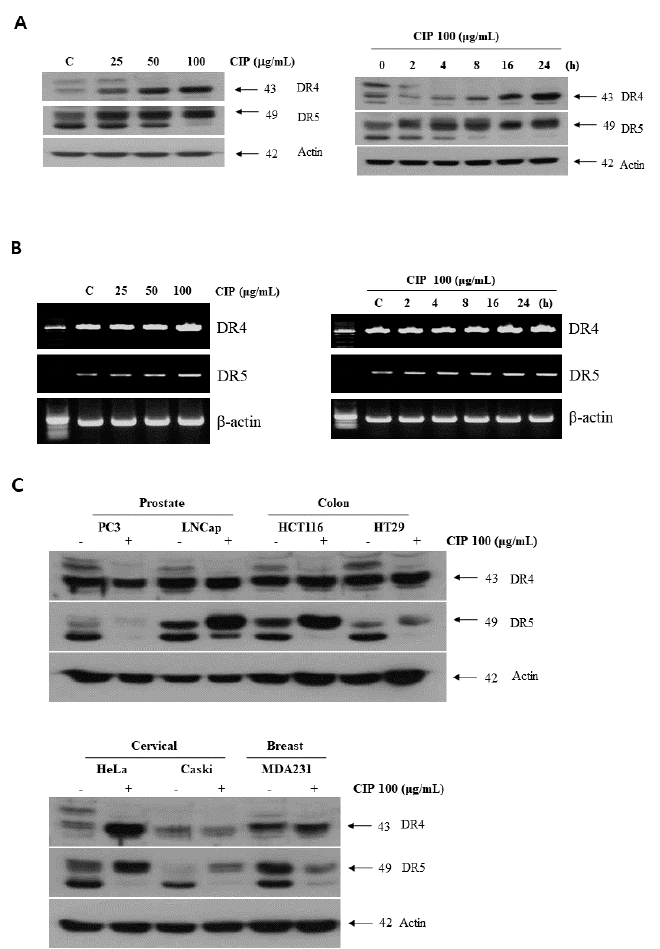
Figure 3. CIP-induced DR5 and DR4 expression. ( A ) A549 cells were treated with various concentrations of CIP ( left ) and with CIP 100 µ g/mL for various time periods ( right ). Whole cell extracts were analyzed for DR4 and DR5 expression by western blotting. ( B ) CIP-induced DR4 and DR5 gene expression. A549 cells were treated with various concentrations of CIP ( left ) and with CIP 100 µ g/mL for various time periods ( right ). Total RNA was extracted and examined for DR4 and DR5 expression by RT-PCR. Actin was used as an internal control to show equal RNA loading. ( C ) Various cancer cell lines were treated with CIP for 24 h and whole cell extracts were analyzed by western blotting. Equal amounts of protein (40 µ g) were separated by SDS-PAGE and